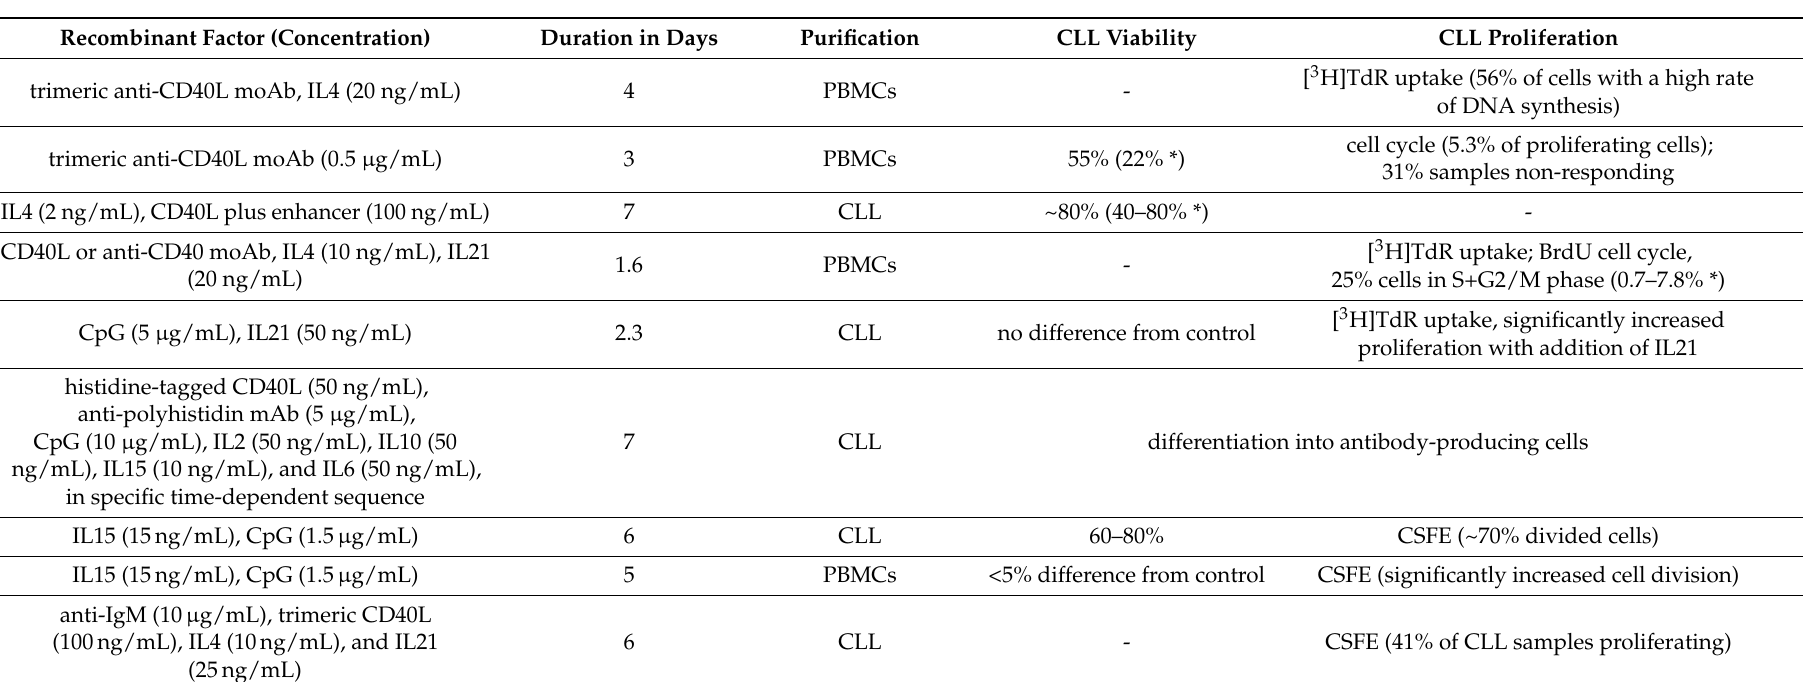
Table 3. In vitro models utilizing CLL-cell stimulation with recombinant factors.